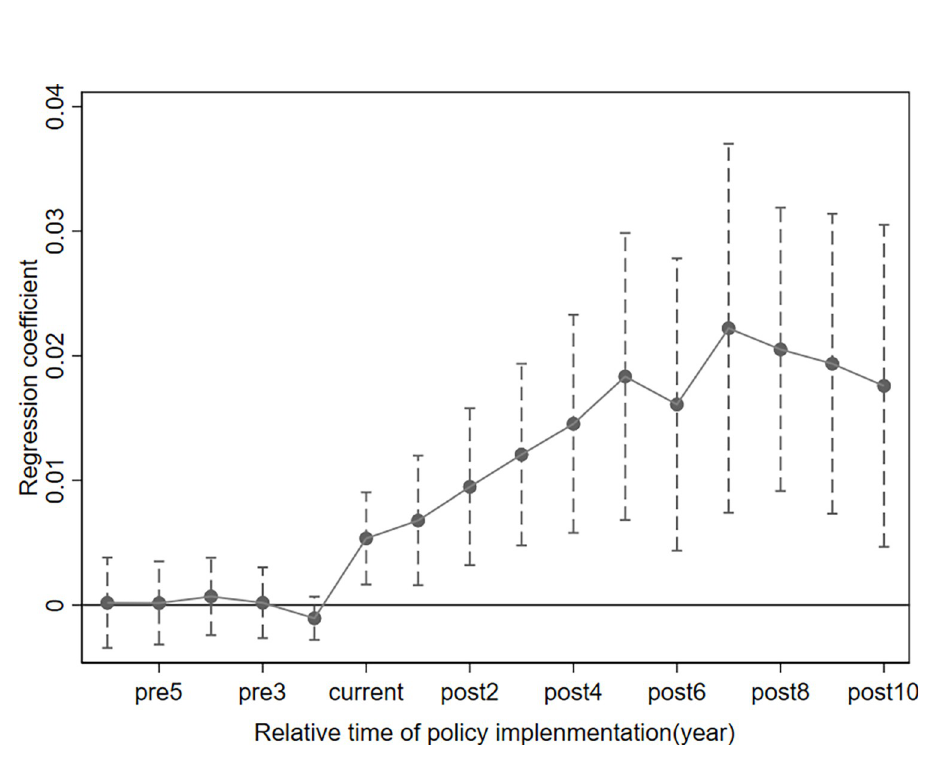
Fig 3. Results of the parallel trends and dynamic effects